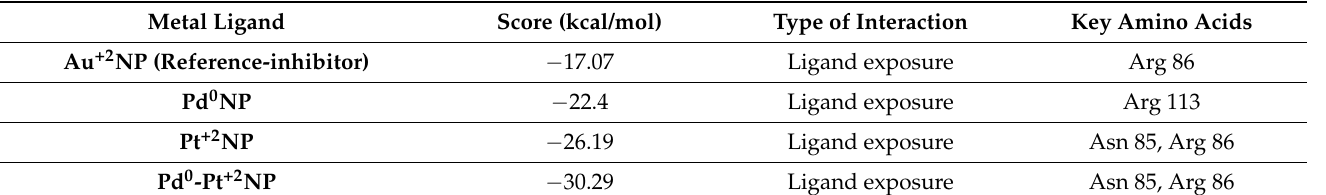
Table 2. Molecular docking of the four dynamic metal models against cysteine proteinase enzyme.